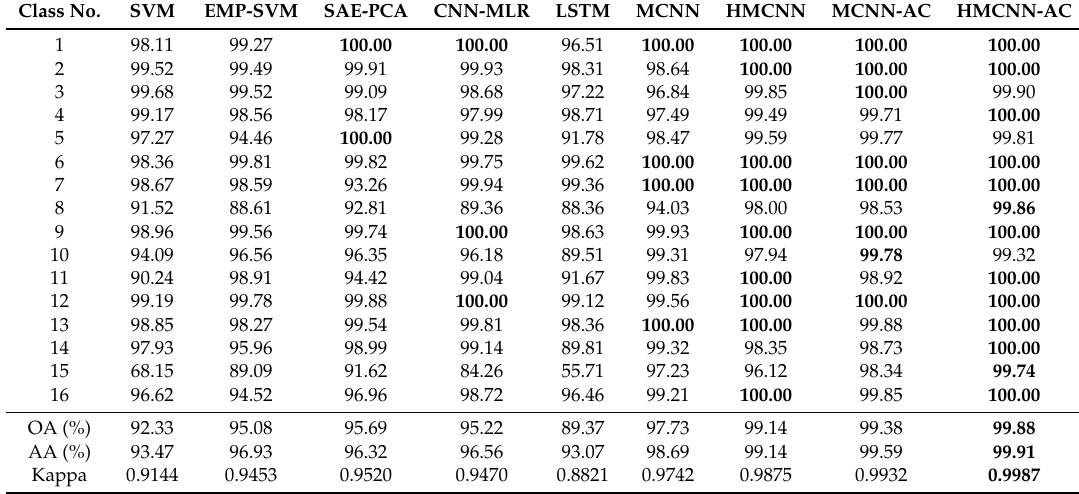
Figure 9. The curves of OA obtained by different layer numbers and hidden units in bidirectional LSTM. The optimal hyperparameter choice for Salinas is two-layer with 64 and 128 hidden units respectively, two-layer with 64 and 64 units for PaviaU, and one-layer with 64 hidden units for KSC due to smaller data size. Table 5. Classification accuracy (%) for Salinas dataset using 5% training samples via different classification algorithms. The three proposed frameworks HMCNN, MCNN-AC and HMCNN-AC outperform other baseline methods in